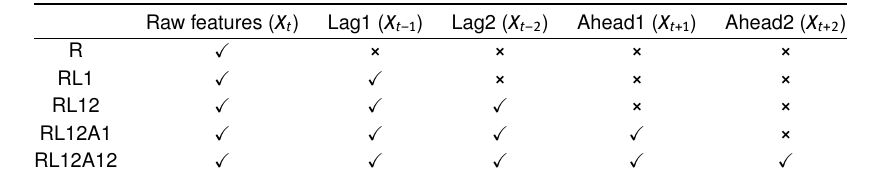
Table 2. Description of five input feature combinations, denoted by ‘R’, ‘RL1’, ‘RL12’, ‘RL12A1’, and ‘RL12A12’, where ✓ and × repre- sent inclusion and exclusion of corresponding features respectively.